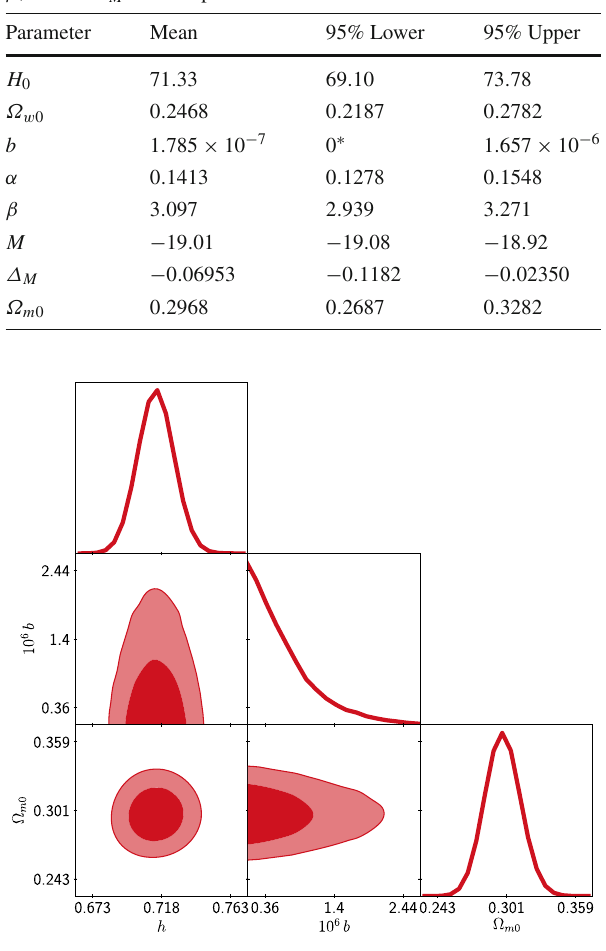
Table 1 Result of the statistical analysis for the joint analysis using SNIa (JLA), H 0 ( z ) and BAO data sets. The best-fit result was obtained = 685 . 3. Here, the nuisance parameters from JLA data α , when χ 2 min β , M and Δ M are also presented